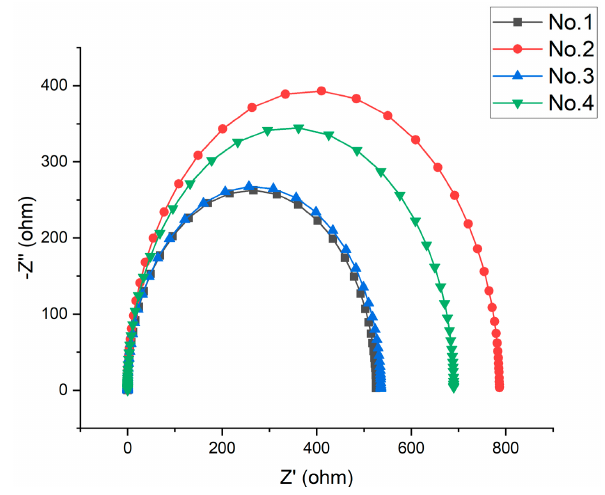
Figure 5. Nyquist diagram of 42CrMo alloy steel electrochemical impedance spectroscopy.